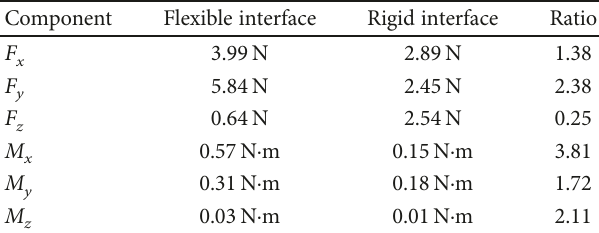
Table 5: Mean values of disturbance amplitude on two